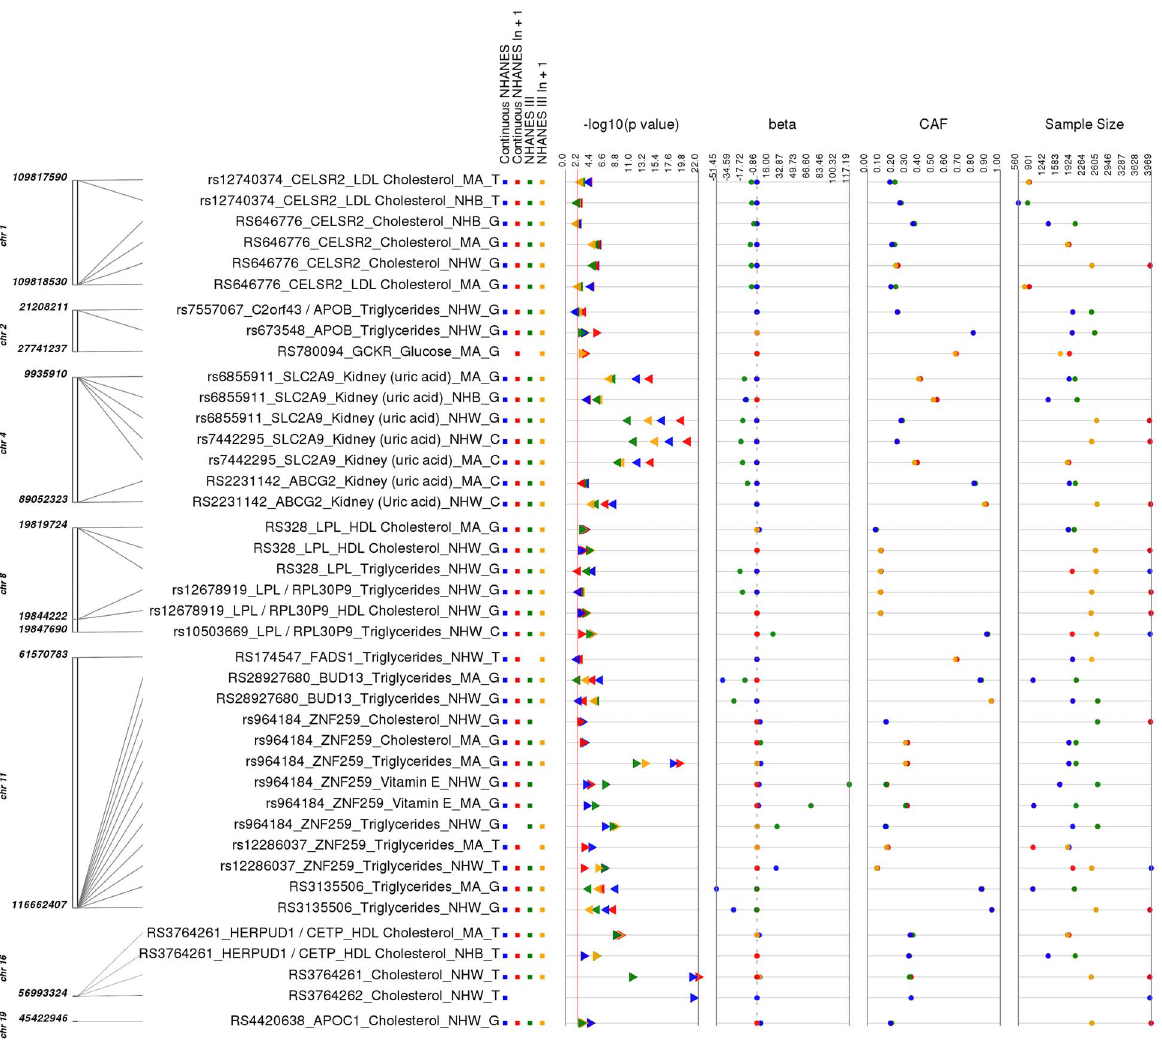
Fig. 2. Replicating results for PheWAS. This is a plot of SNP-phenotype associations observed in both NHANES III and Continuous NHANES with p-value , 0.01, for SNPs with an allele frequency . 0.01, and a sample size . 200, for the same race-ethnicity, phenotype-class, and direction of effect. Plotted are results where the significant SNP-phenotype association matches a previously reported SNP-Phenotype association. The first column indicates the chromosome and base pair location of the SNP. The second column indicates the SNP ID, the associated phenotype-class, the self- reported race-ethnicity (NHW = Non-Hispanic Whites, NHB = Non-Hispanic Blacks, or MA = Mexican Americans), and the coded-allele. The next column contains a colored box if association results were available for natural log transformed Continuous NHANES (Continuous NHANES ln + 1), un- transformed Continuous NHANES phenotypes, NHANES III untransformed phenotypes (NHANES III), or transformed NHANES III phenotypes (NHANES III ln + 1) (see methods for more details on phenotype transformation). The next column indicates the p-value for each association, and the triangle direction indicates whether the association had a positive (triangle pointed to the left) or negative direction of effect (triangle pointed to the right). The following columns indicate magnitude of the effect (beta), the coded allele frequency (CAF), and the sample size for the